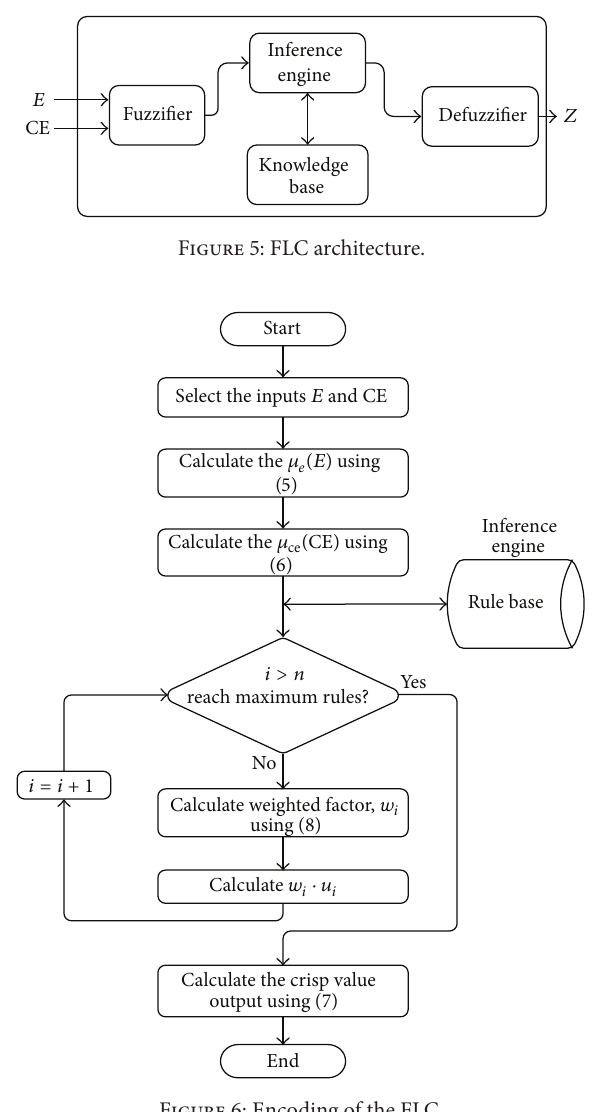
Figure 6: Encoding of the